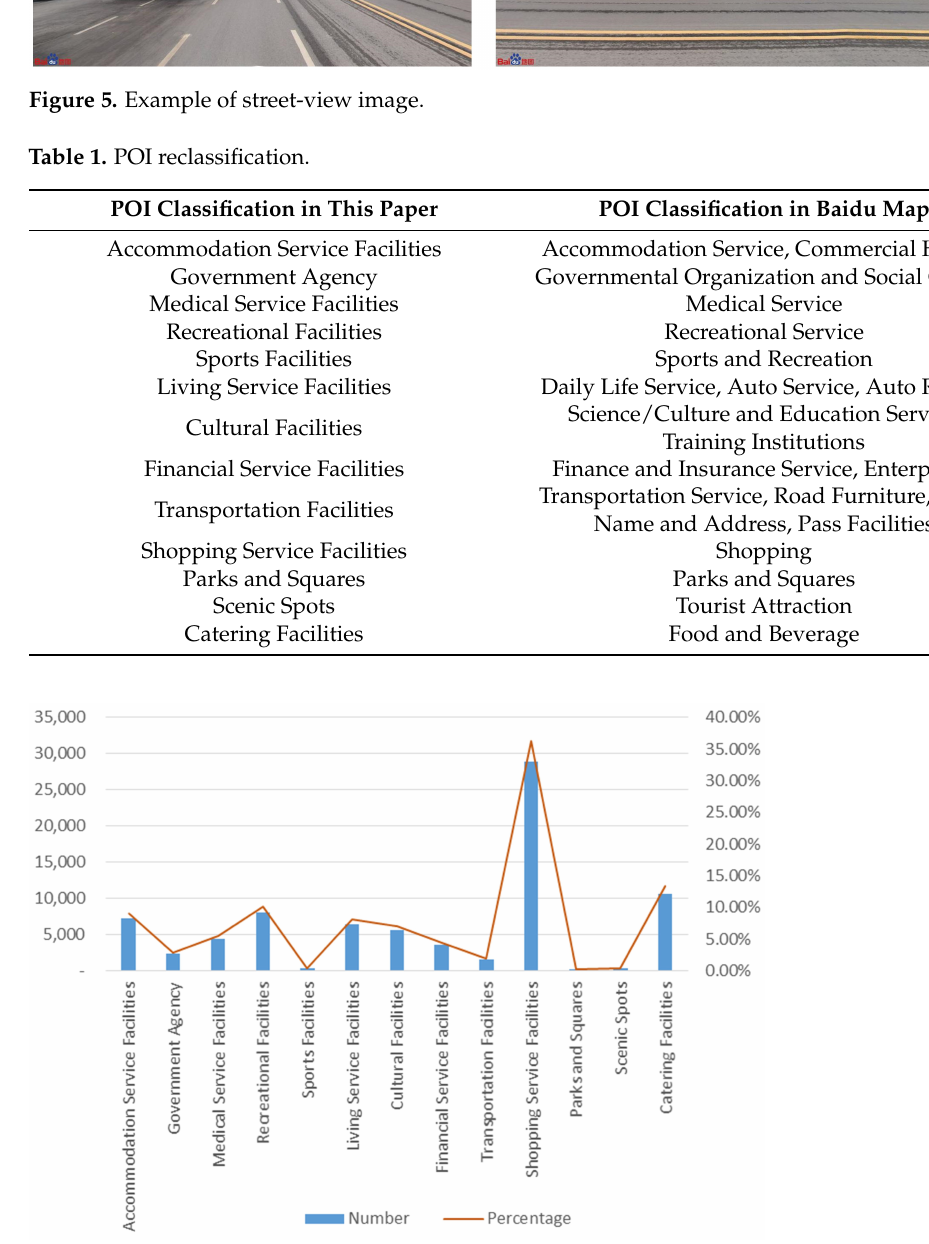
Figure 6. Percentage of POIs in each